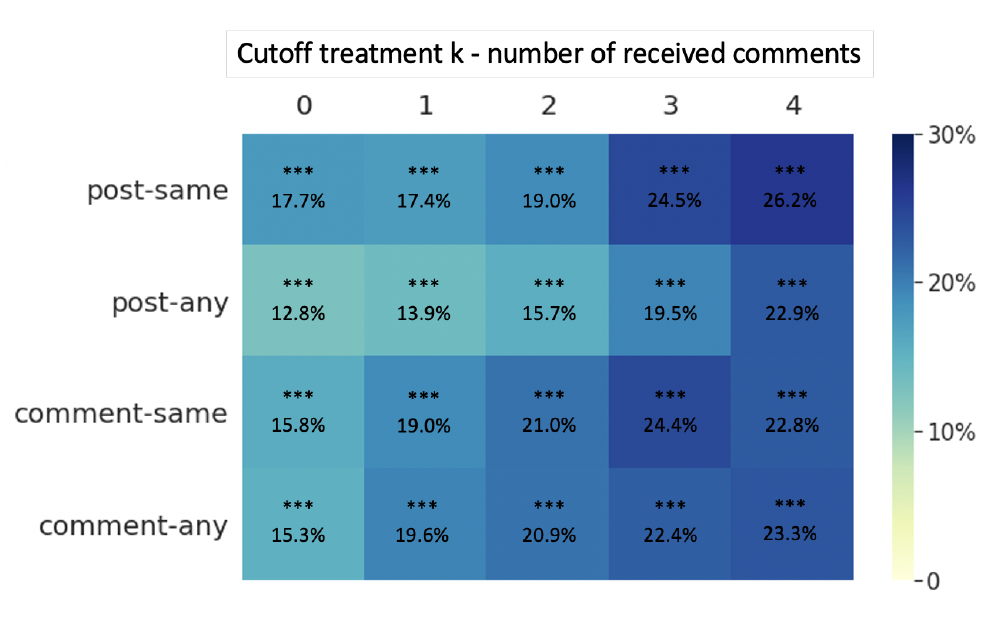
Figure 3. Effect size of the difference in return probability between more comments group and fewer comments group in different treatment definitions (more comments group: number of received comments > k , fewer comments group: number of received comments ≤ k . *** p < 0.001.